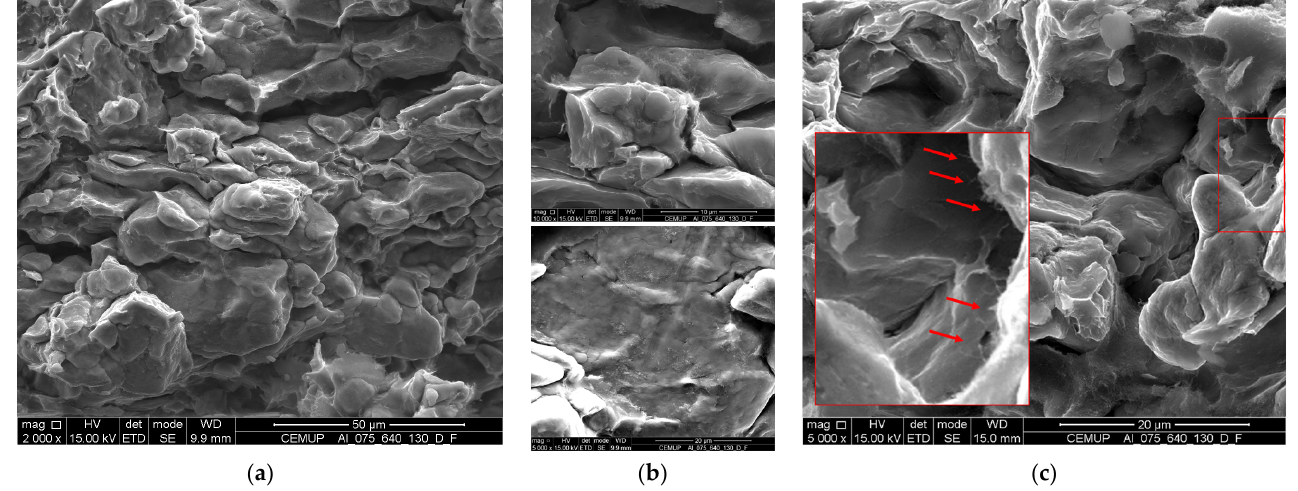
Figure 9 . Secondary electrons image obtained by scanning electron microscopy (SEM) of different areas of the nanocomposite fracture surface of tensile samples, being ( a ) low magnification ( b ) higher magnifications and ( c ) a detail showing elongated CNT.